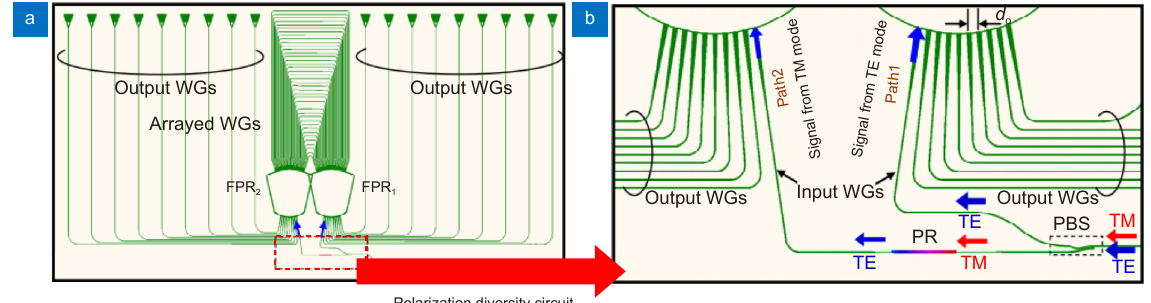
Fig. 14 | ( a ) Graphical pattern of the hybrid MUX/DEMUX containing a bi-directional AWG and a polarization diversity circuit. ( b ) The magnified image of the PDC joining the two input WGs of the bi-directional AWG. Figure reproduced with permission from ref. 104 , Optica Publishing Group, under the Optica Open Access Publishing